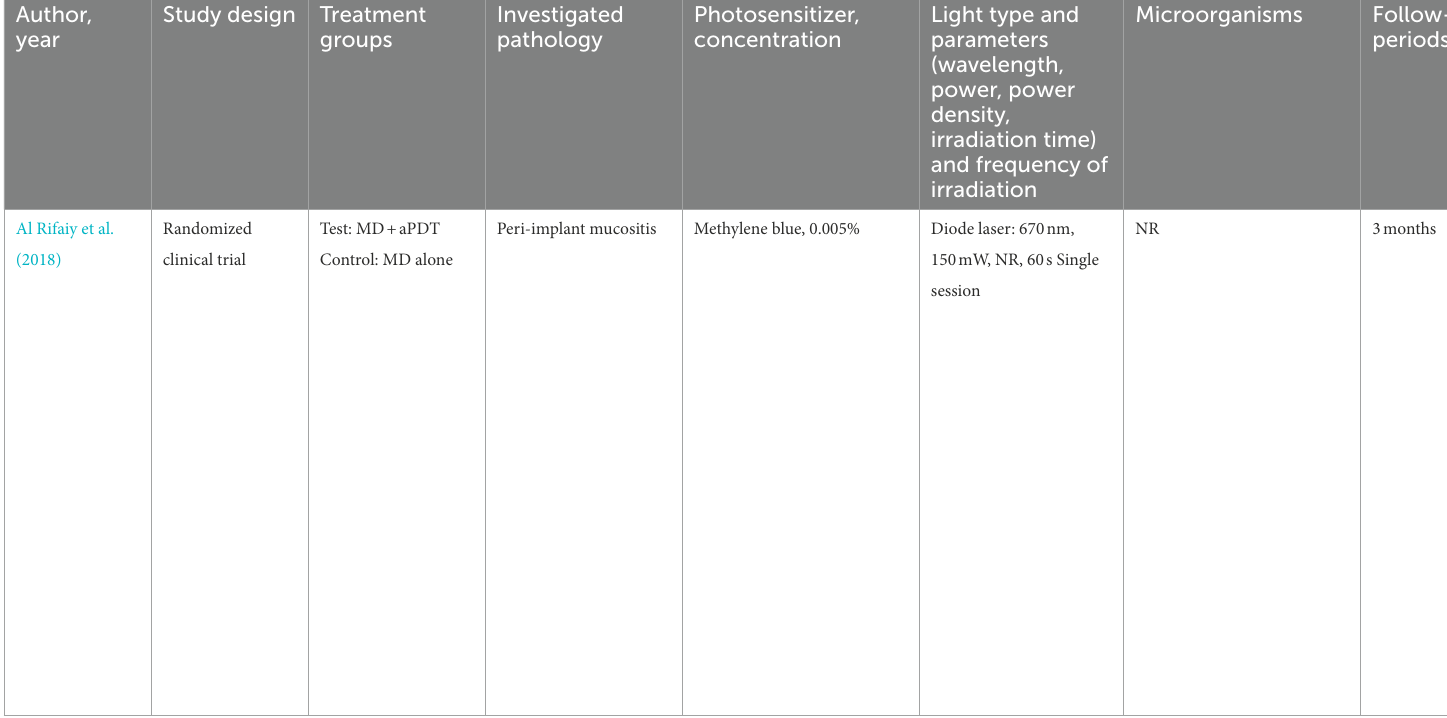
TABLE 2 aPDT treatment in patients with peri-implant